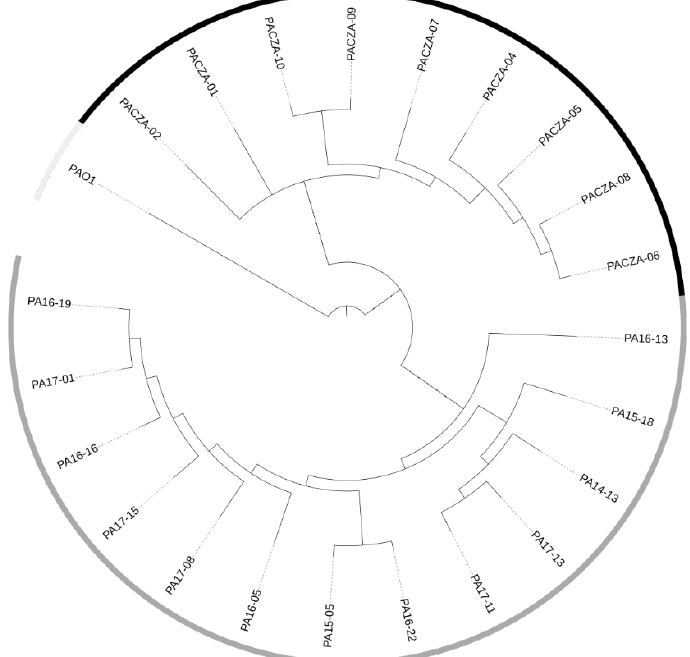
Figure 2. Core-genome maximum-likelihood phylogenetic tree of all P. aeruginosa isolates and the P. aeruginosa PAO1 reference genome. The units of the scale are single-nucleotide polymorphisms (SNPs) by position. Ceftazidime/avibactam (CZA) phenotypes of P. aeruginosa isolates are highlighted by shaded squares: resistant (black), susceptible (dark grey), and not applicable (light grey). CZA, ceftazidime/avibactam.